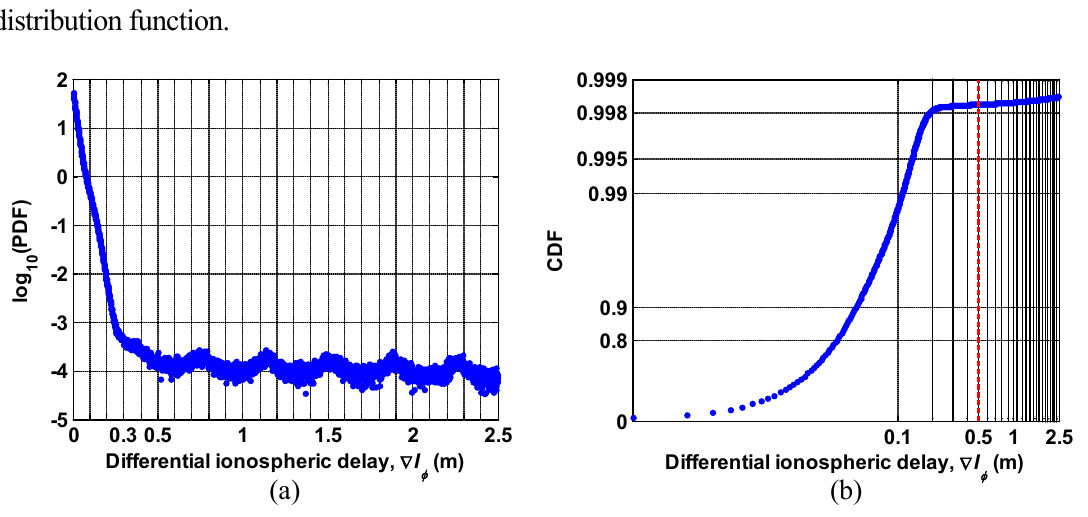
∇ , derived from data φ